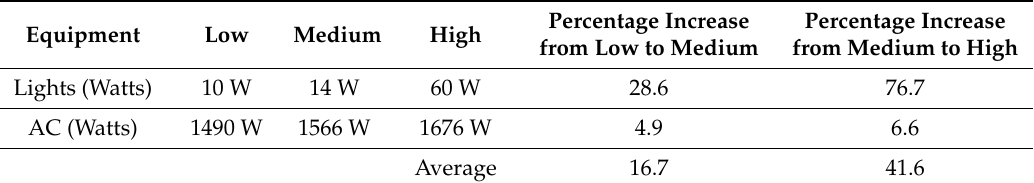
Table 8. Comparison of equipment based on electricity